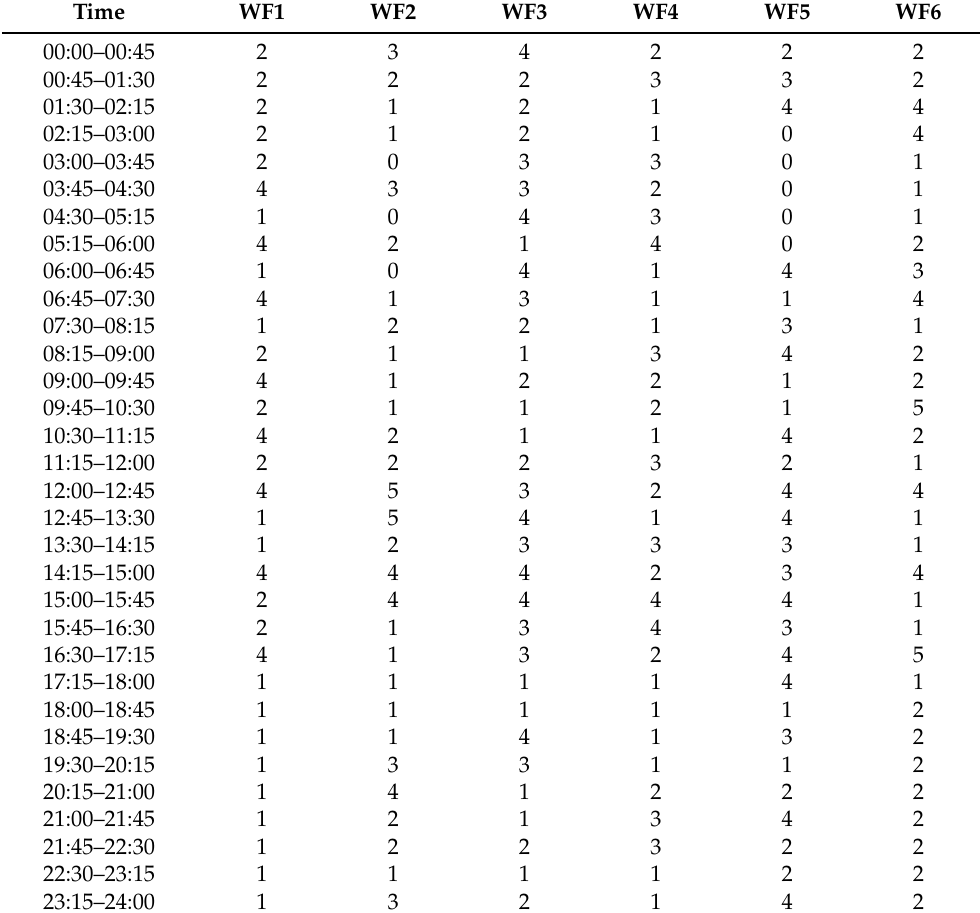
Table 4. Results of wind farm dynamic